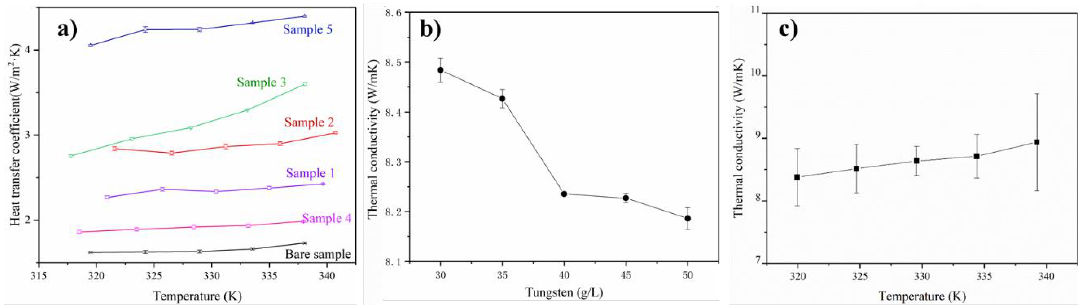
Figure 10. ( a ) Heat transfer coefficient of specimens after being fouled; ( b ) Thermal conductively of specimens varied with the temperature; ( c ) Thermal conductively of specimens varied with tungsten content.